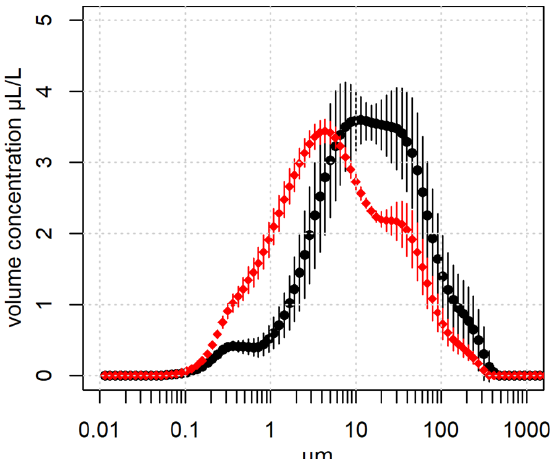
Figure 4. The average particle size distribution (volume-based) of the non-prepared (black) and pre-treated surface sediment samples (red; disaggregation of flocculi, removal of carbonates, Mn-/Fe- oxides and Mn-/Fe-hydroxides).